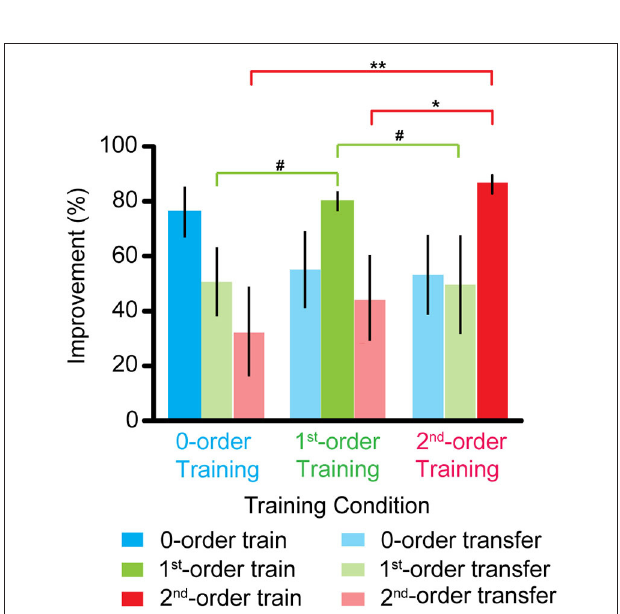
FIGURE 3 | Improvements of the zero-, first-, and second-order disparity threshold after the zero-, first-, and second-order disparity training. Error bars represent standard error across the subjects. * p < 0.05; ** p < 0.01; # 0.05 < p <